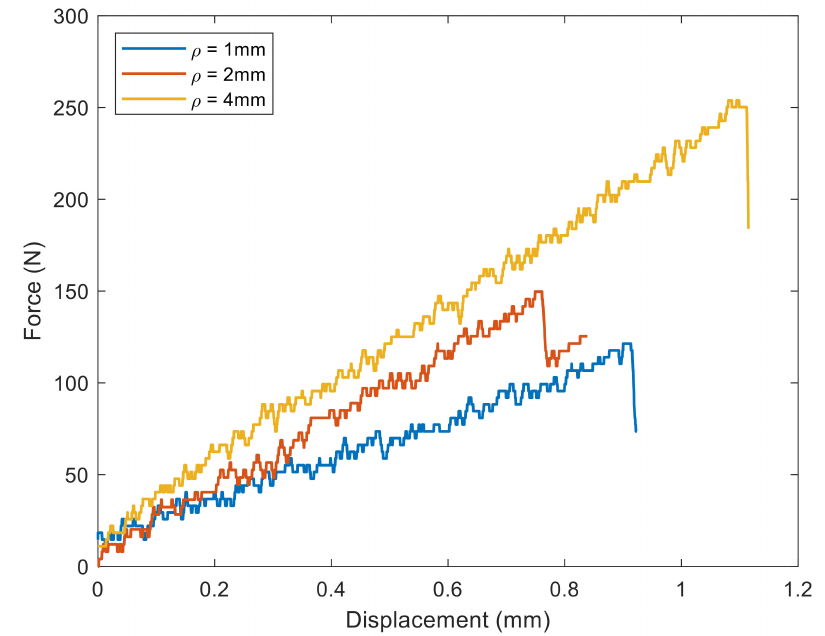
Figure 5. Example of force-displacement curves obtained in fracture tests of spruce wood ( β = 40 ◦